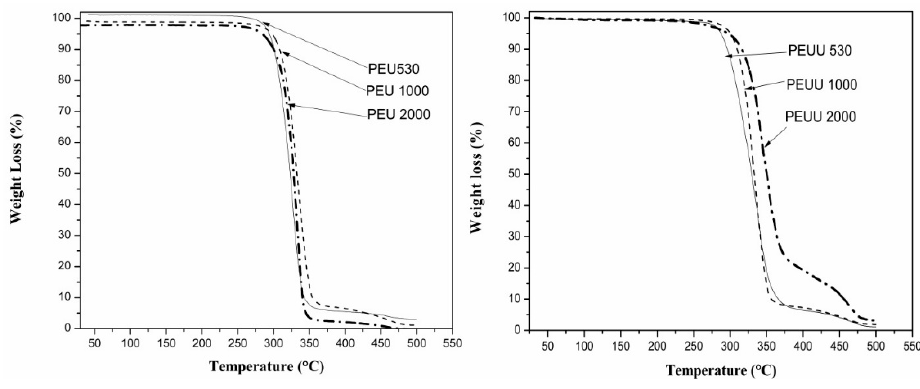
Figure 2. TGA curves of the synthesized polymers. ( Left ) PEUs, ( Right ) PEEUs.